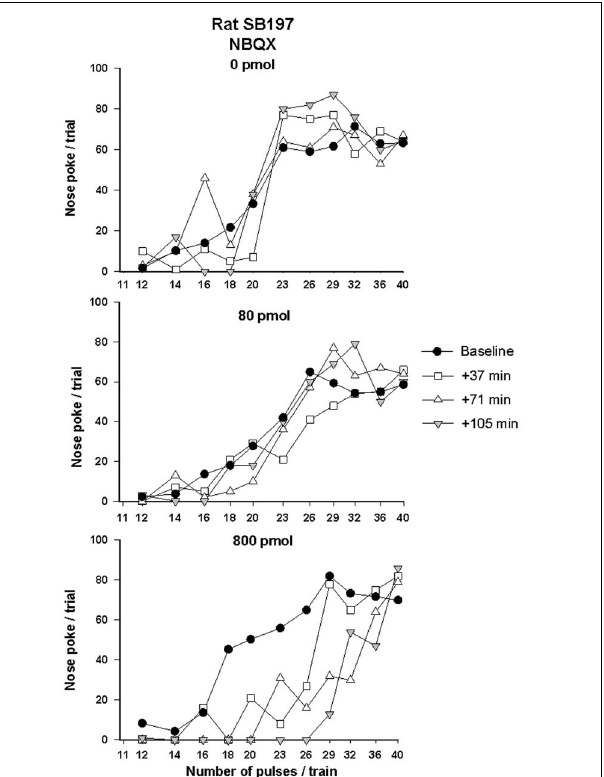
FIGURE 2 | Rate-frequency curves obtained from rat SB197 prior to (baseline) and after injection of vehicle (top panel, 0nmol) and two doses (80 and 800pmol/0.5 µ l/side, middle and bottom panels respectively) of NBQX. For clarity only four curves, including averaged baseline curves, are shown. The x -axis represents the number of pulses per train on a log